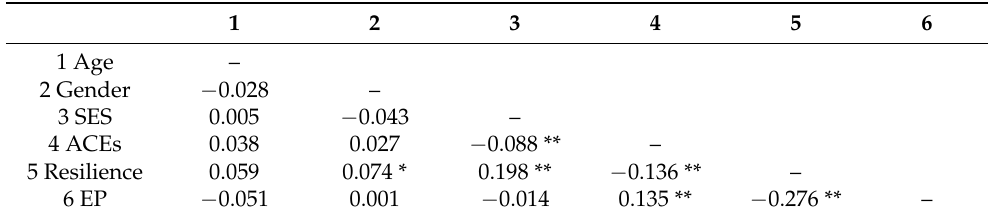
Table 2. Bivariate correlations among the main